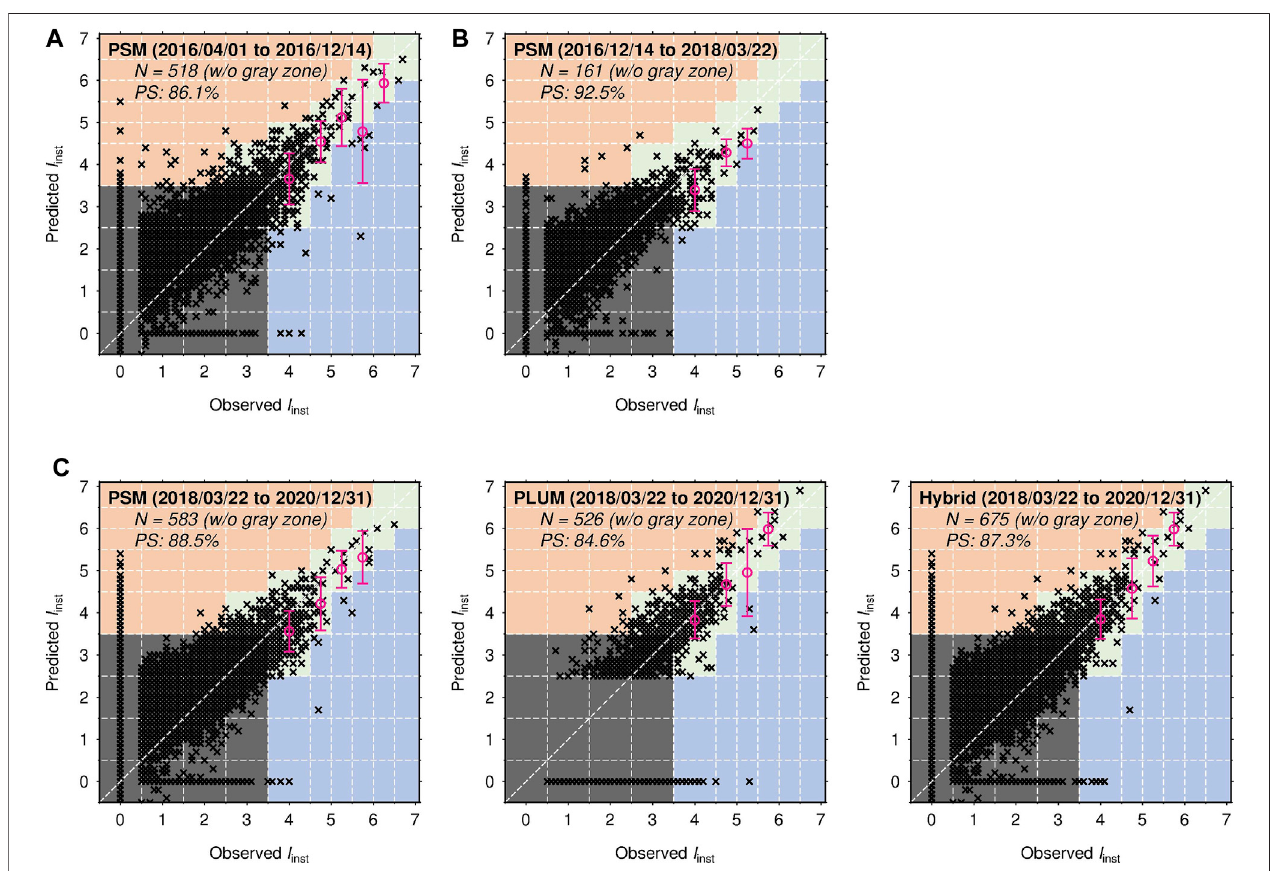
FIGURE 4 | The same fi gure as Figure 3 but using the fi nal ground motion prediction results.